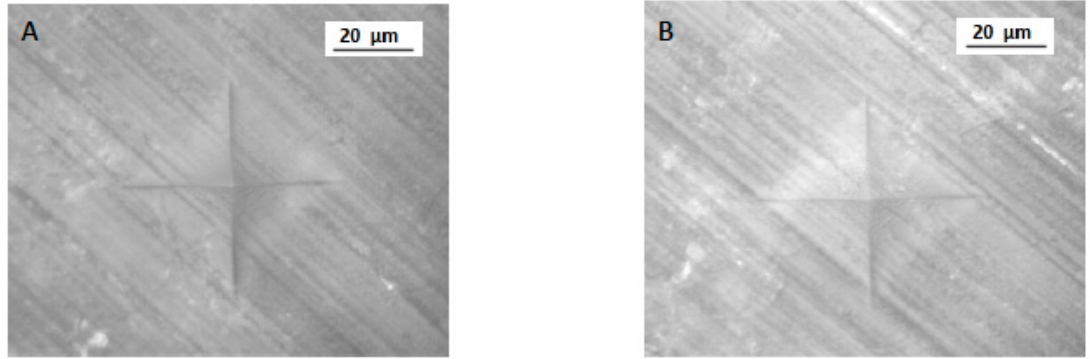
Figure 5. VHN indentation ( A , B ) for conventionally fabricated samples (Group CV). A and B are two different samples from the same group. Table 1. Comparison of surface roughness (Ra) and micro-hardness (VHN) among study groups (CC, 3D, and CV).